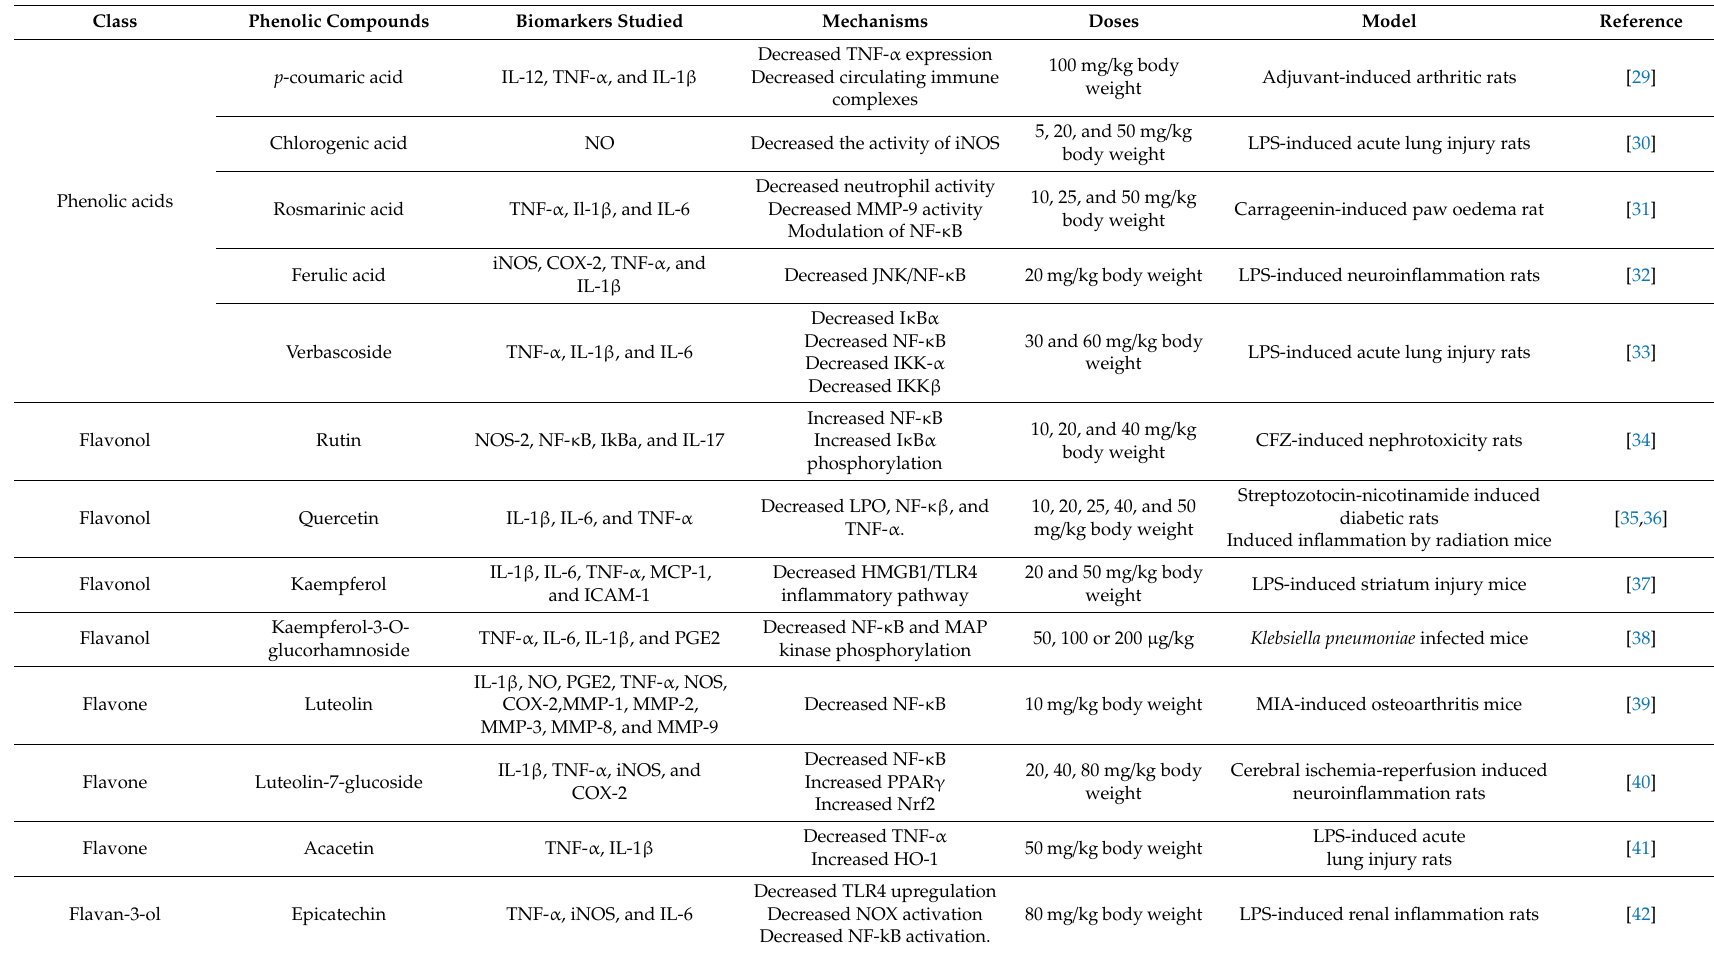
Table 1. Modulation of inflammatory response of phenolic compounds tested on in vivo